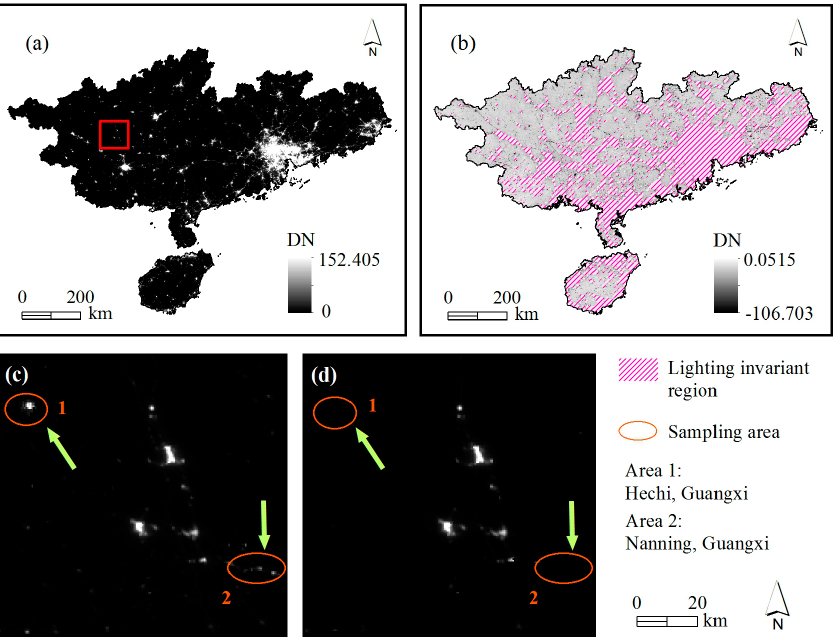
Figure 5. ( a ) The corrected VIIRS nighttime light data for South China in 2014. The region bounded by the red rectangle is the sampling area. ( b ) The difference between the corrected and original lighting. The red shaded area is the lit area where the lighting value is not modified. ( c ) The original; and ( d ) corrected imagery of sampling region are Hechi (area No. 1) and Nanning (area No. 2). The two example lit areas that were removed during correction are indicated by red circles and yellow arrows.